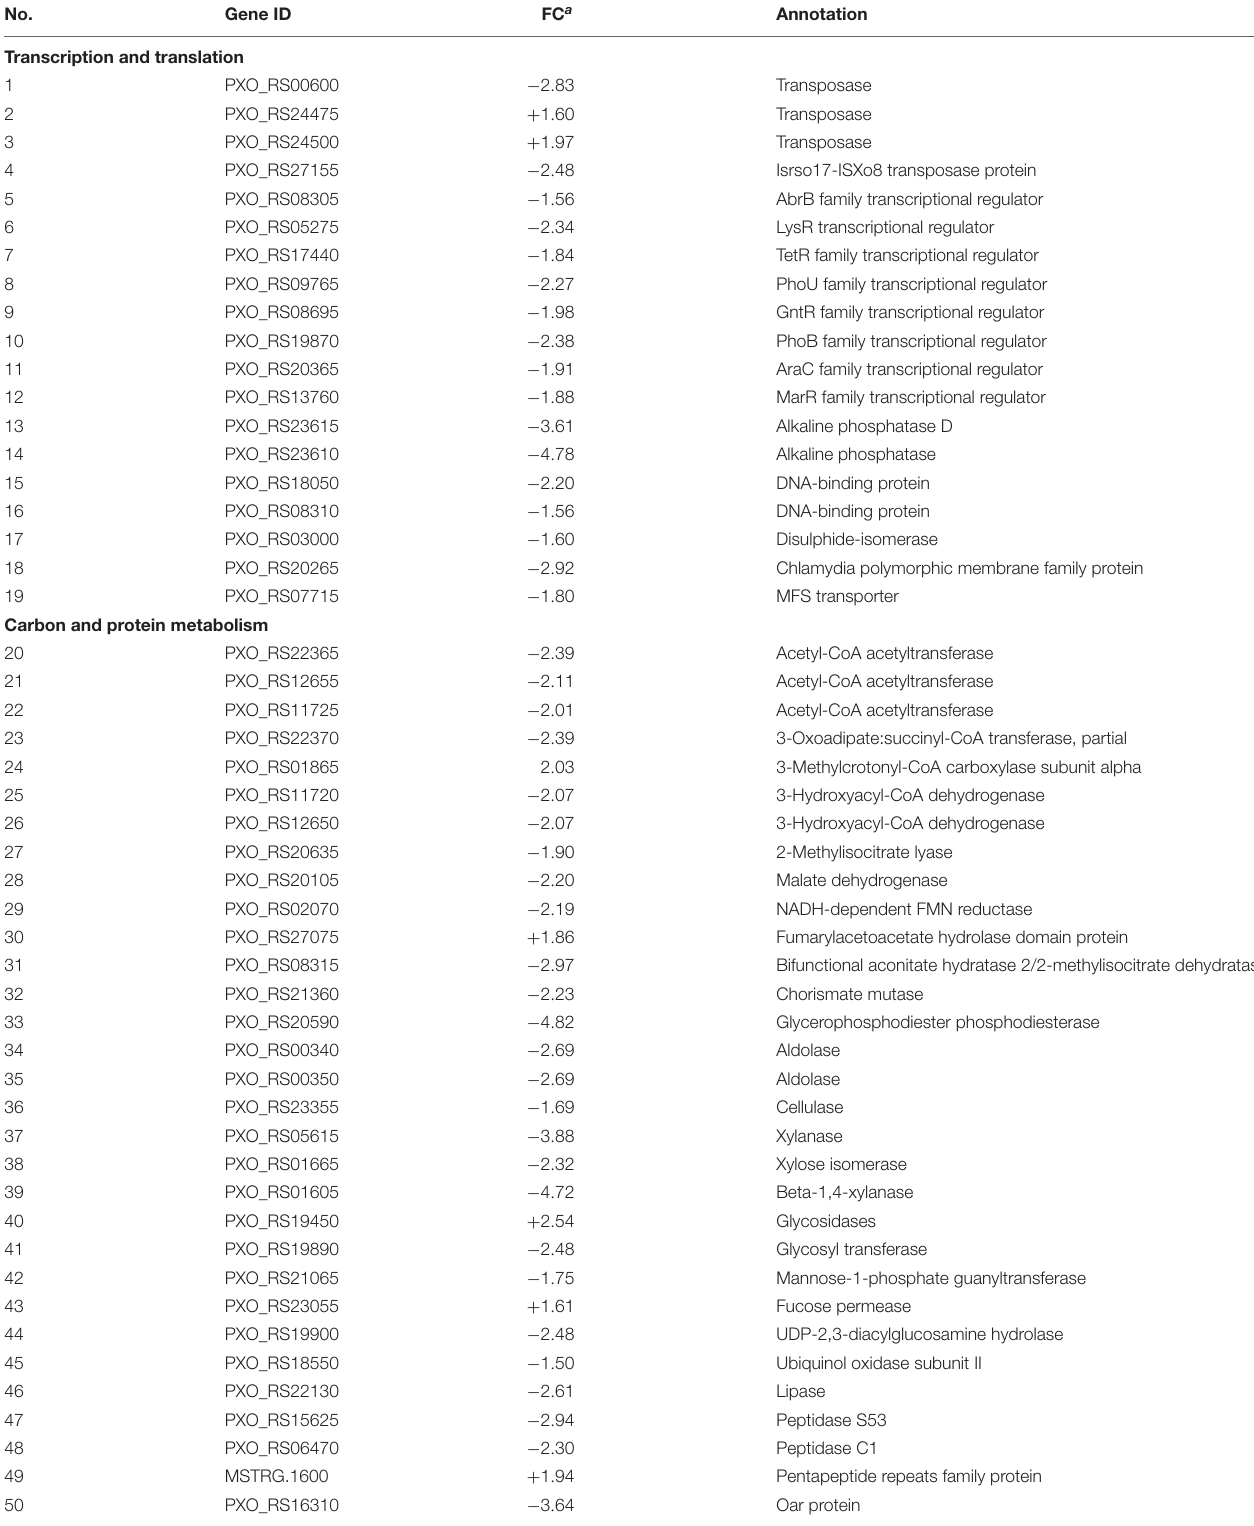
TABLE 1 | Differentially expressed genes in Xoo treated with